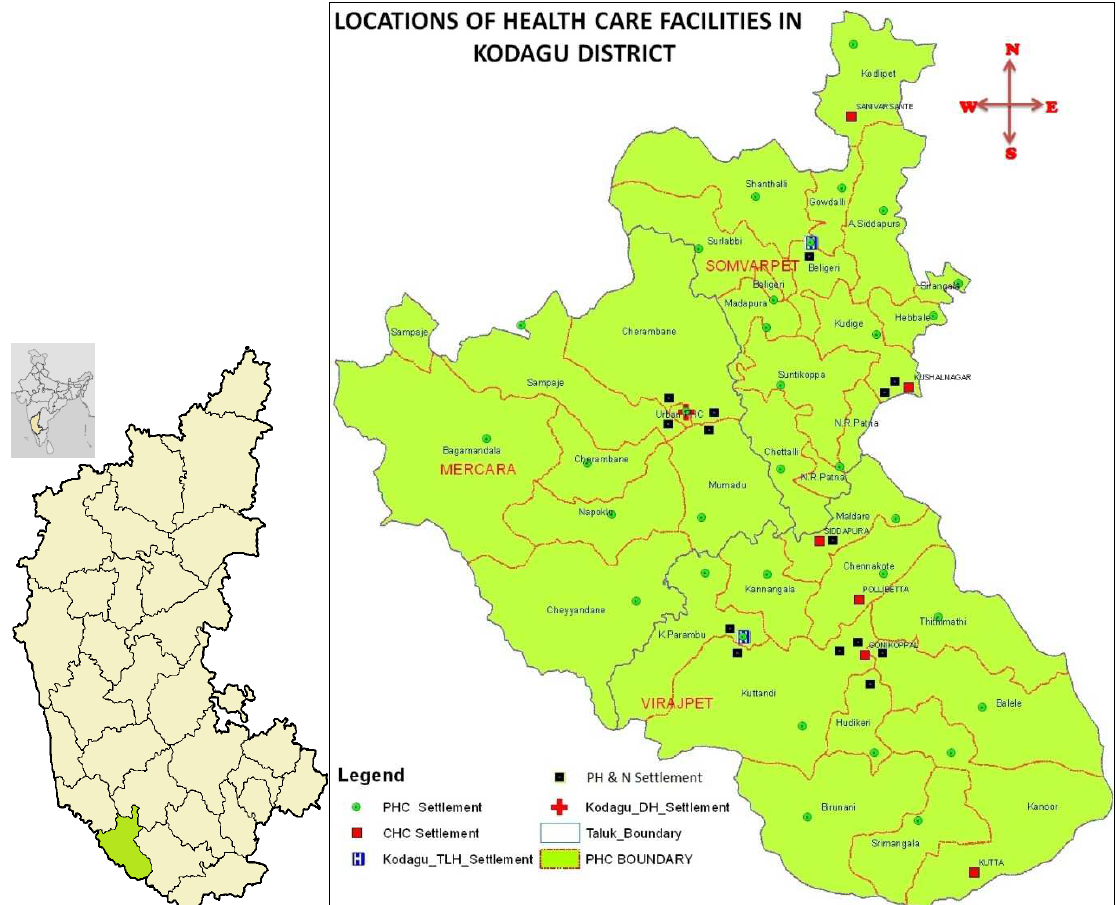
Figure 1. Major healthcare facilities selected for the healthcare management studies in Kodagu